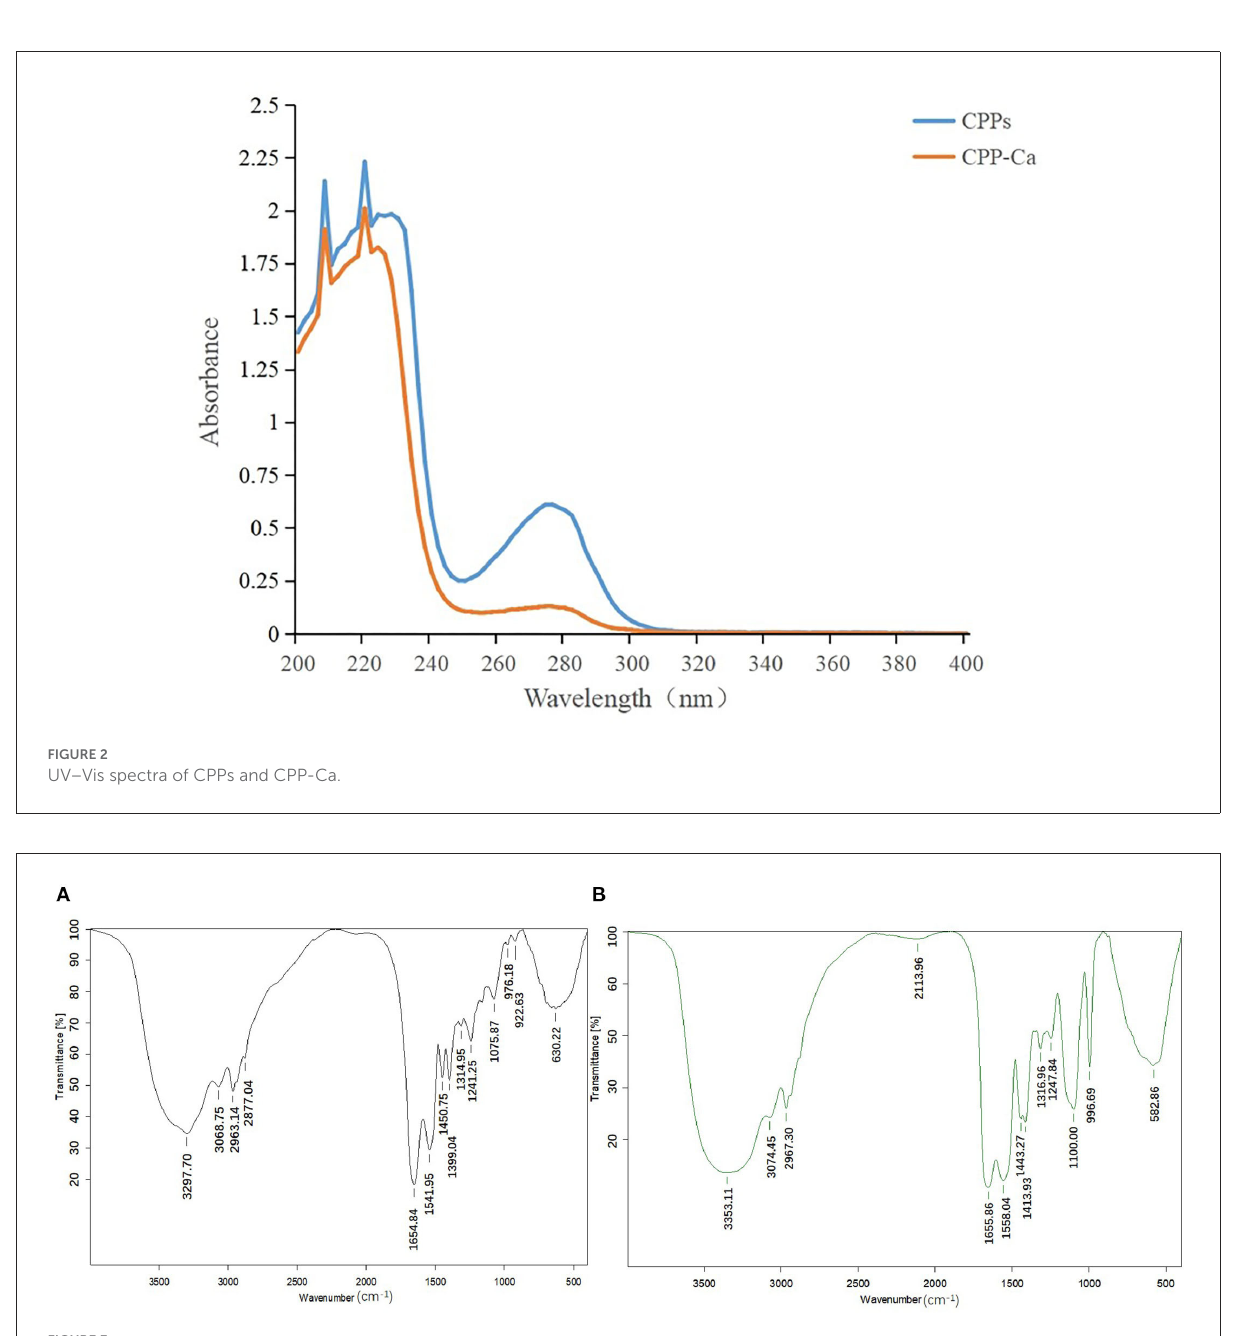
Orthogonal experimental